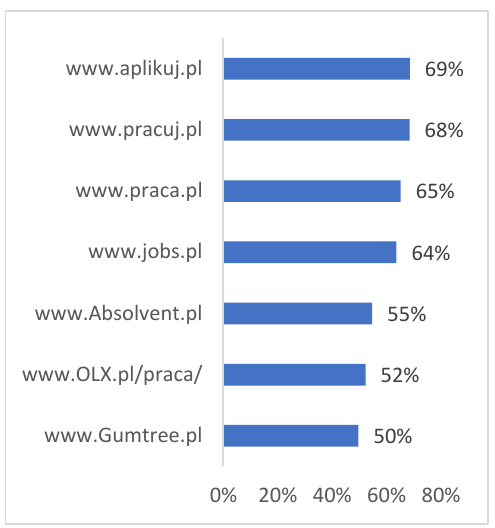
Figure 3. Ranking of the most popular HR portals in Poland in 2022; Source: own work. The portals fulfilled about 50% of user requirements.